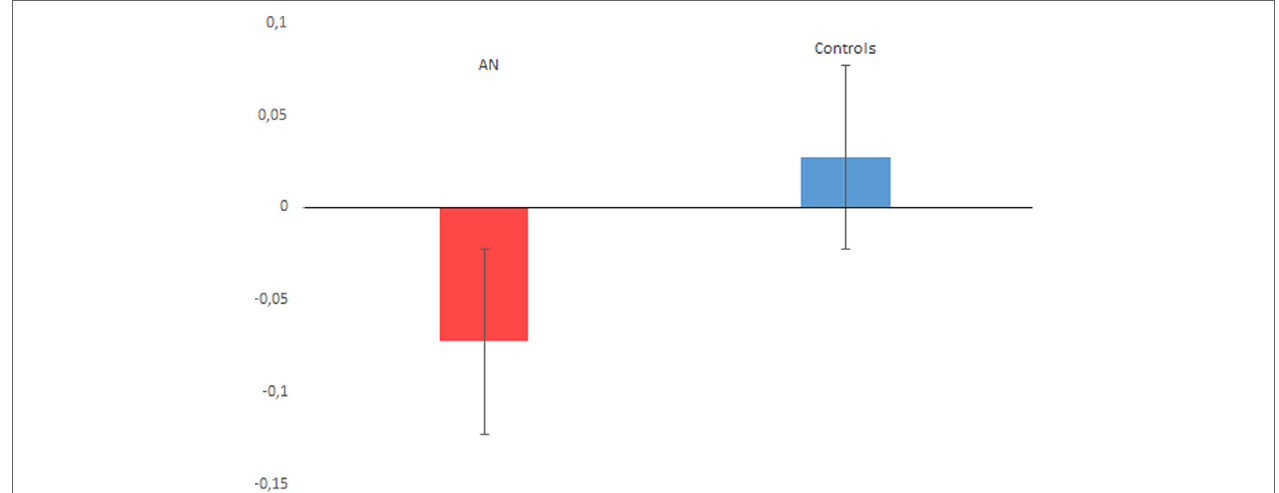
FigUre 2 | The figure plots the proportional bias performance associated with anorexia nervosa (AN) and control participants. A negative value indicates time underestimation, while a positive value indicates time overestimation. Vertical bars denote ±